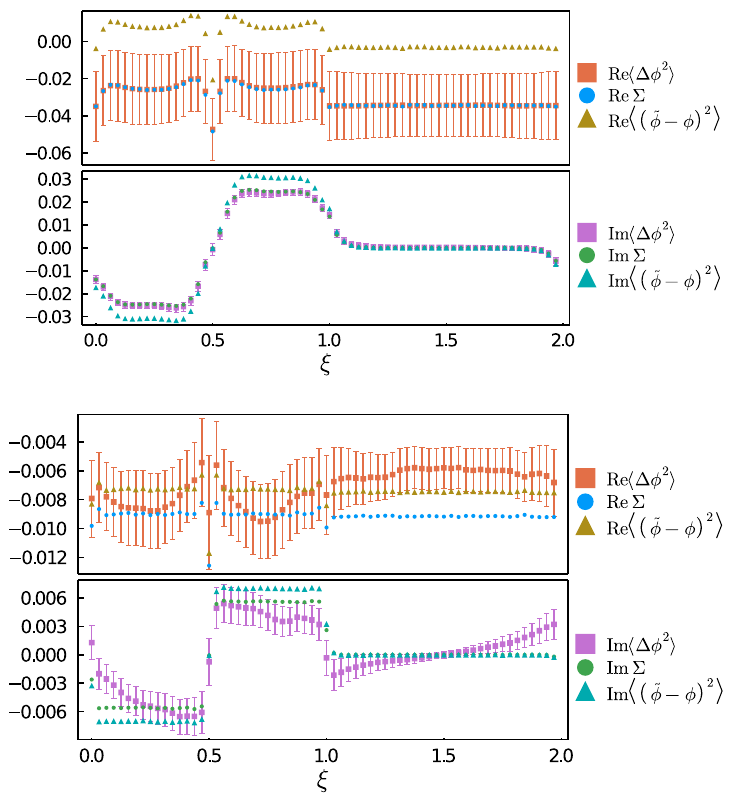
Figure 5 . Comparison of the finite Langevin step-size artifacts in the equal-time correlator ∆ φ 2 = h φ 2 i CL −h φ 2 i QM to the estimates of that error based on eq. (3.33). The filled triangles denote the full estimate including the terms proportional to (cid:15) 2 , which provide the correct qualitative behavior but systematically overestimate ∆ φ 2 . On the other hand the leading order expression Σ , proportional to (cid:15) , shown as filled circles captures the error even quantitatively within the statistical uncertainty. The position along the contour is parametrized by ξ , which for ξ < 1 points to real-time values and for 1 < ξ < 2 refers to imaginary times. (top) Estimation of the errors in the free theory (harmonic oscillator) using ∆ τ L = 10 − 2 , as well as (bottom) for the anharmonic oscillator at λ = 24 with ∆ τ L = 10 − 3 . In both cases, the data is based on 1000 separate trajectories each of total length τ L = 200